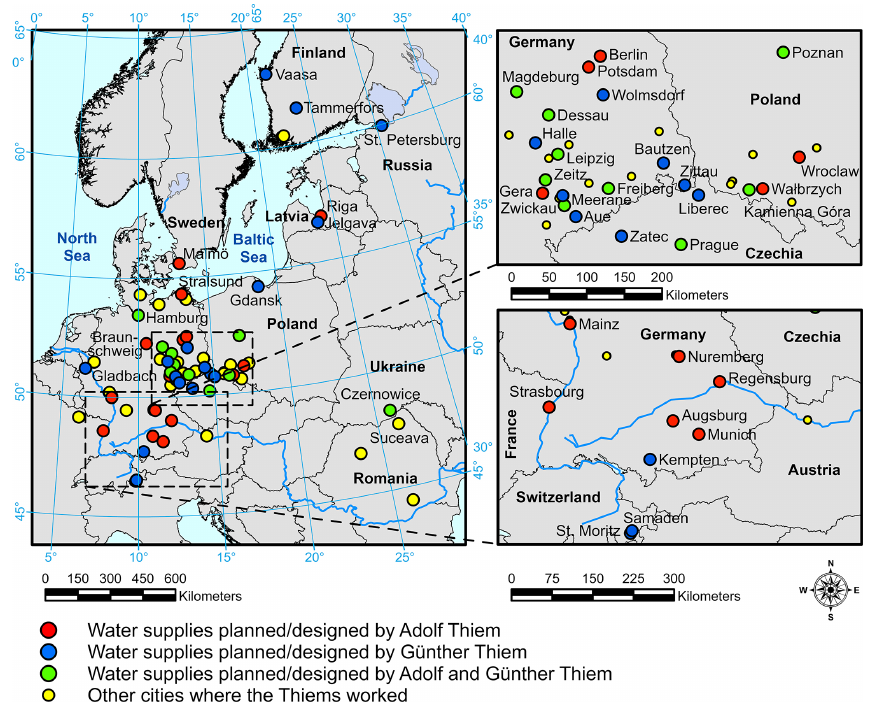
Figure 12. Map of waterworks planned and designed by Adolf and Günther Thiem (data credits: Europe NUTS 0 Boundaries from Esri; Michael Bauer Research GmbH; rivers/lakes from